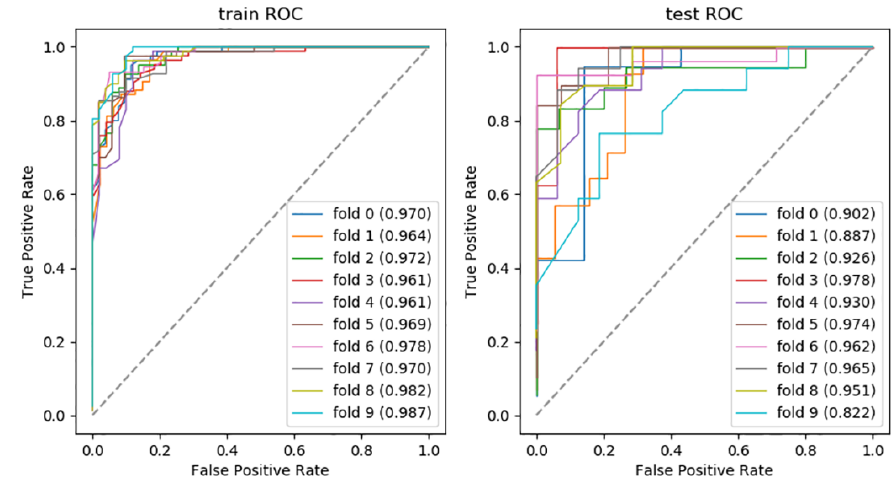
Figure 3. The AUC of optimal discriminative model.